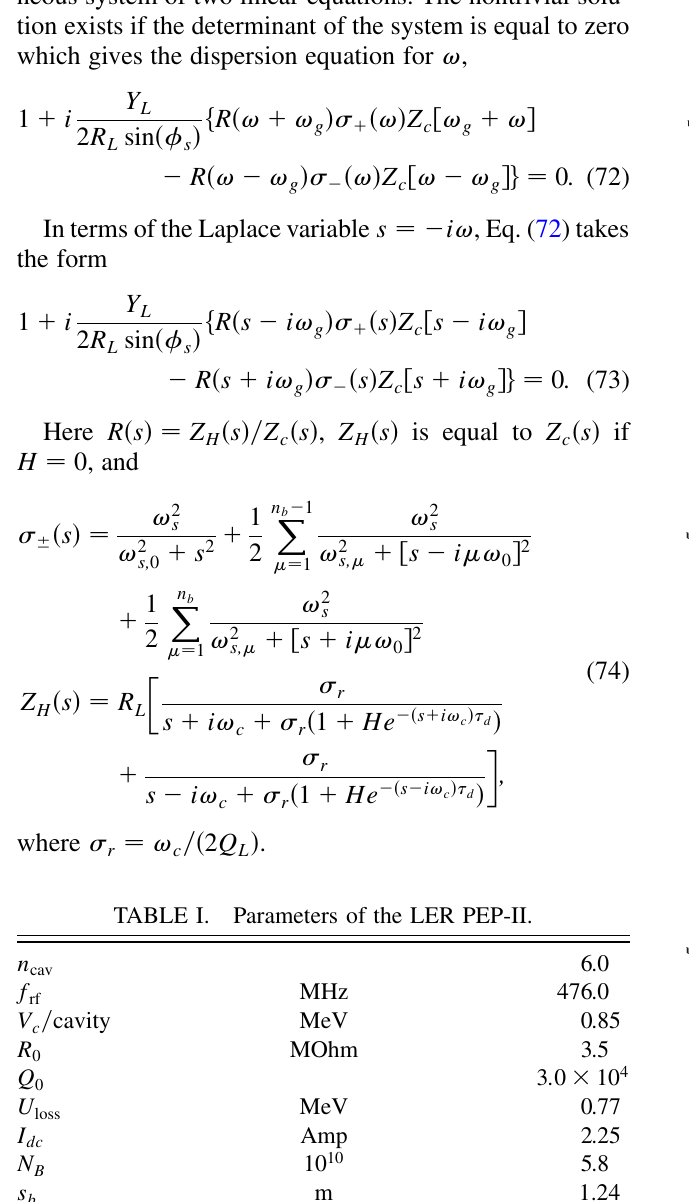
FIG. 5. Growth rate vs beam current. The FB gain (top